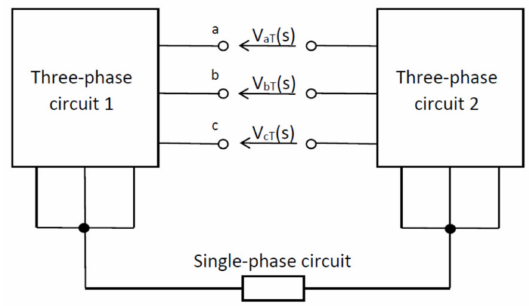
Figure 3. No-load three-phase circuit in the Laplace domain once the asymmetrical three-phase port S is removed.